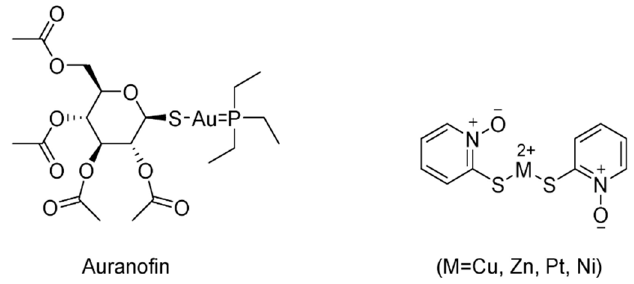
Figure 24. Structures of representative USP14/UCLH5 inhibitors.